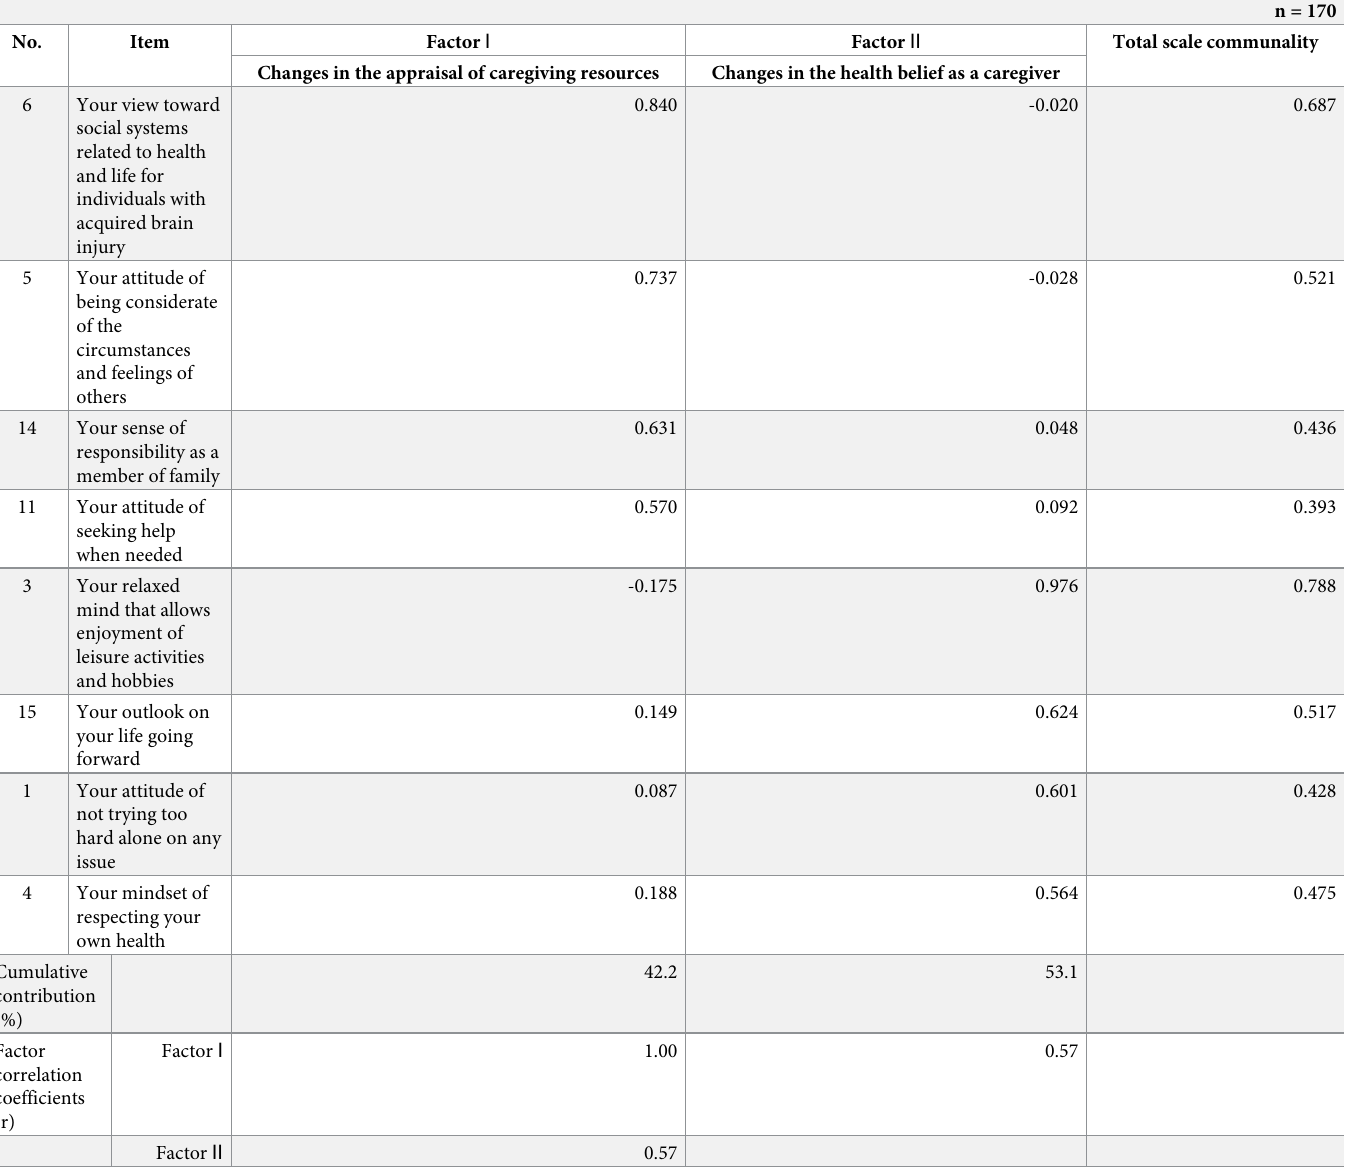
Table 4. Exploratory factor analysis of “the life change adaptation